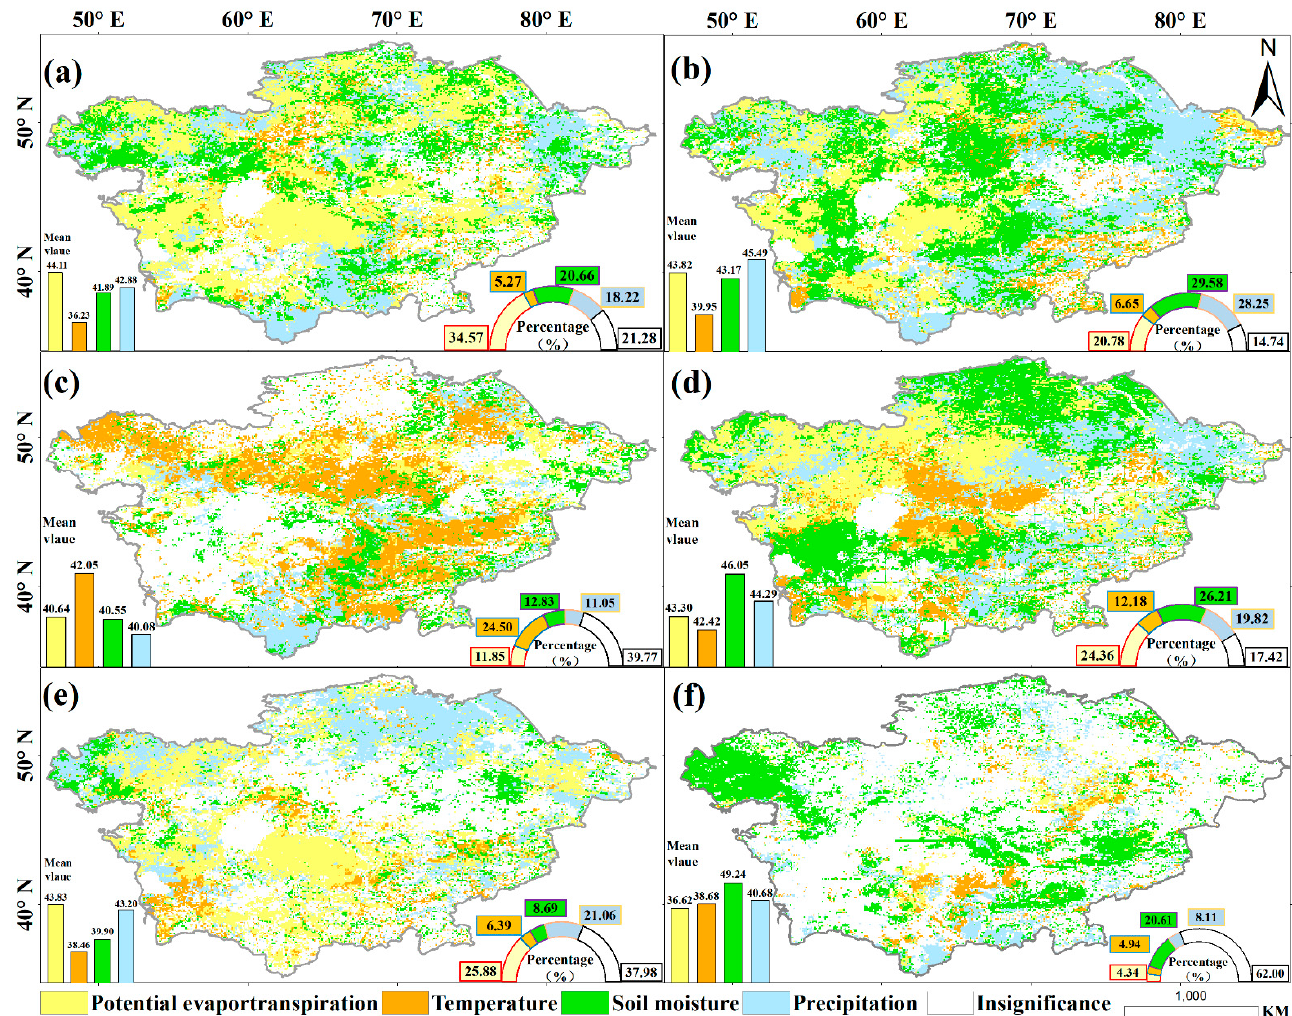
Figure 8. The contributions of hydrothermal conditions to vegetation changes at the annual ( a ) and growing season ( b ) scales, and in spring ( c ), summer ( d ), autumn ( e ), and winter ( f ), and the proportions of different factors’ main areas of contribution in the total study area (pie chart), together with the average contribution value (mean value) of hydrothermal factors.